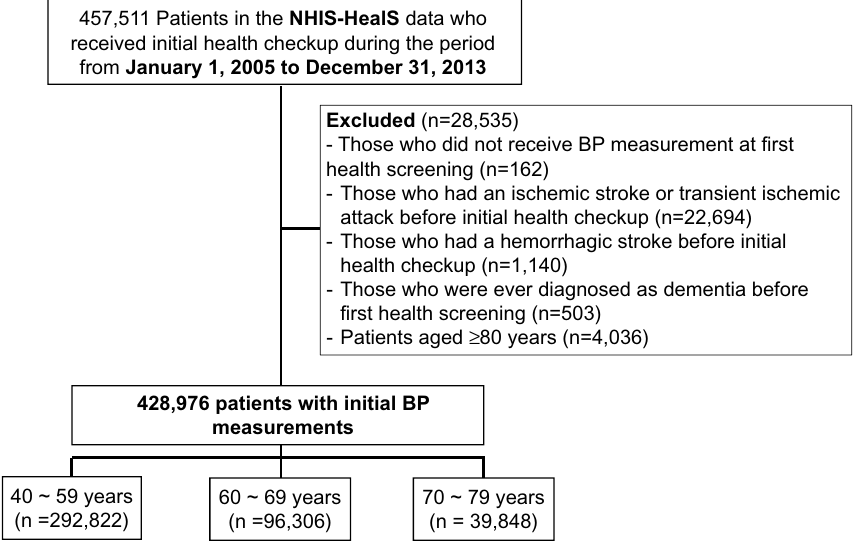
Figure 1. Flowchart of the study population. BP blood pressure, NHIS-HealS National Health Insurance Service-Health Screening